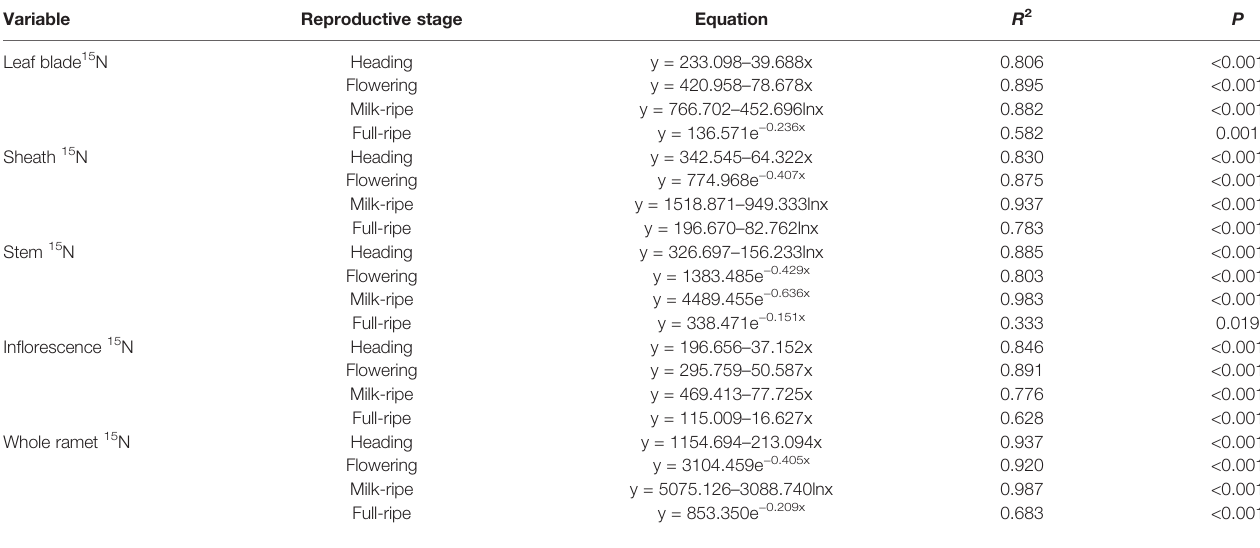
TABLE 5 | Regression equations among translocated 15 N (ng) in different parts of basipetal reproductive ramets and the position order of the connected acropetal vegetative ramets at four reproductive stages ( n = 16).